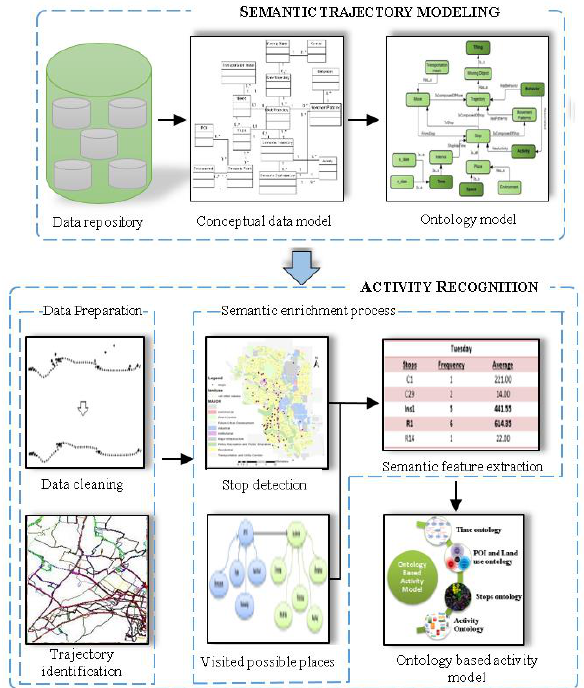
Figure 1. Proposed methodology.